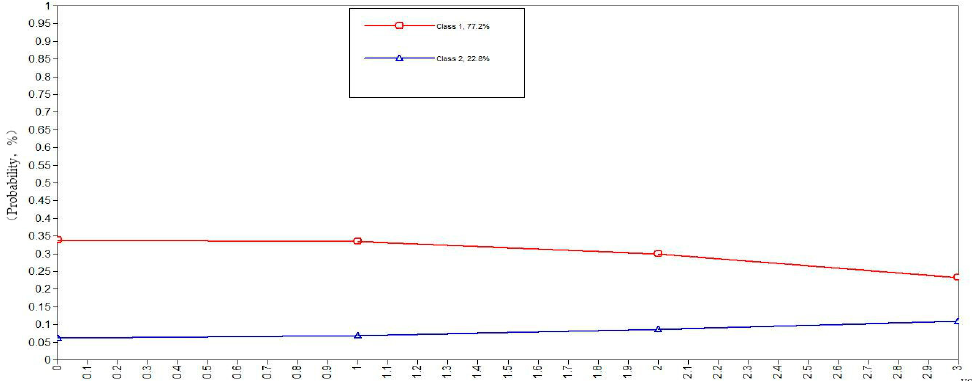
Figure 2. Evolution trends of the elderly with relatively negative health behaviors.